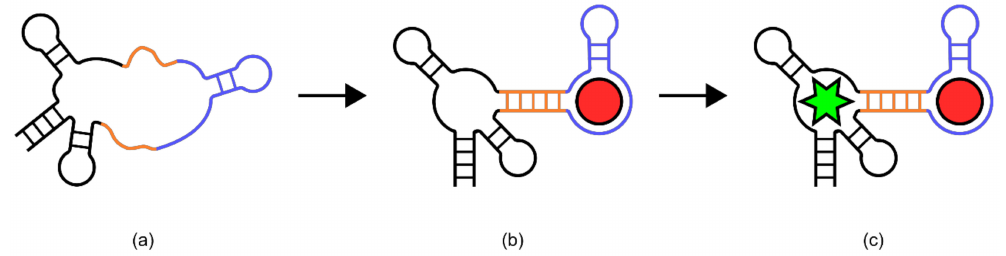
Figure 10. General Spinach based biosensors. ( a ) The Spinach aptamer (black) is disrupted with linker sequences (orange) and a ligand binding aptamer (blue), inhibiting its ability to bind the fluorophore 3,5-difluoro-4-hydroxybenzylidene imadazolinone (DFHBI). ( b ) Coordination of the target ligand (red circle) to the ligand binding aptamer provides sufficient stability to allow the linker regions to assemble. This in turn allows the Spinach aptamer to form its native secondary structure. ( c ) The reformation of the Spinach aptamer allows the coordination and activation of DFHBI (green star), resulting in ligand dependent fluorescent signal generation. Figure adapted from Paige, et al.